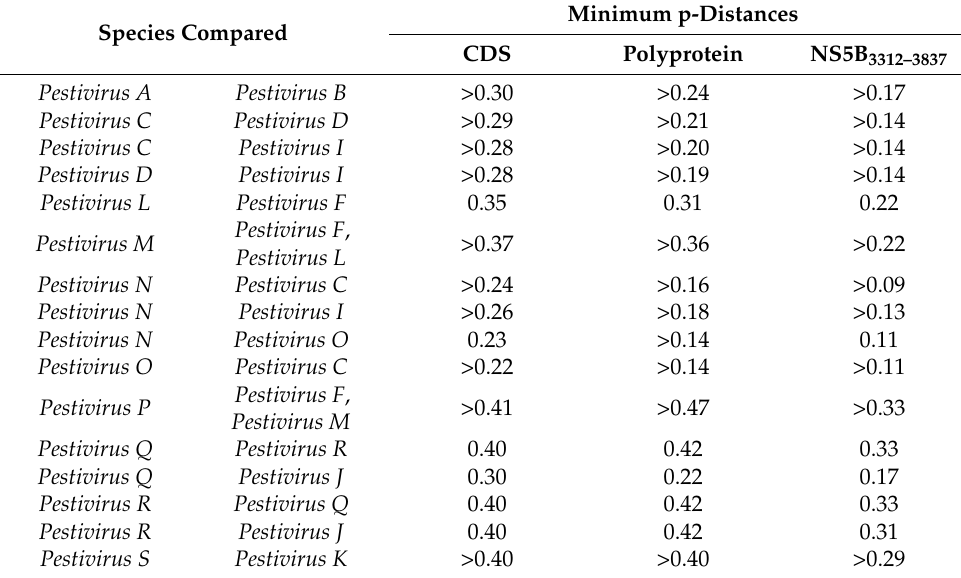
Table 5. Minimum p-distances between members of selected pestivirus